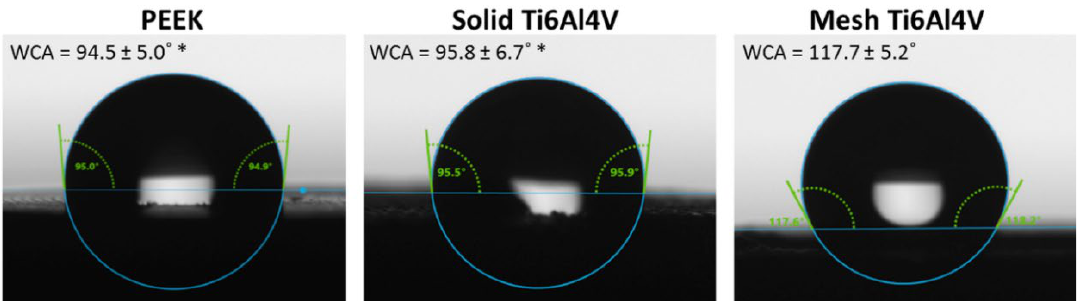
Figure 3. Water contact angle measurements performed for tested materials (* statistically different results compared to mesh Ti6Al4V sample, according to One-way ANOVA followed by Tukey’s multiple comparison test).